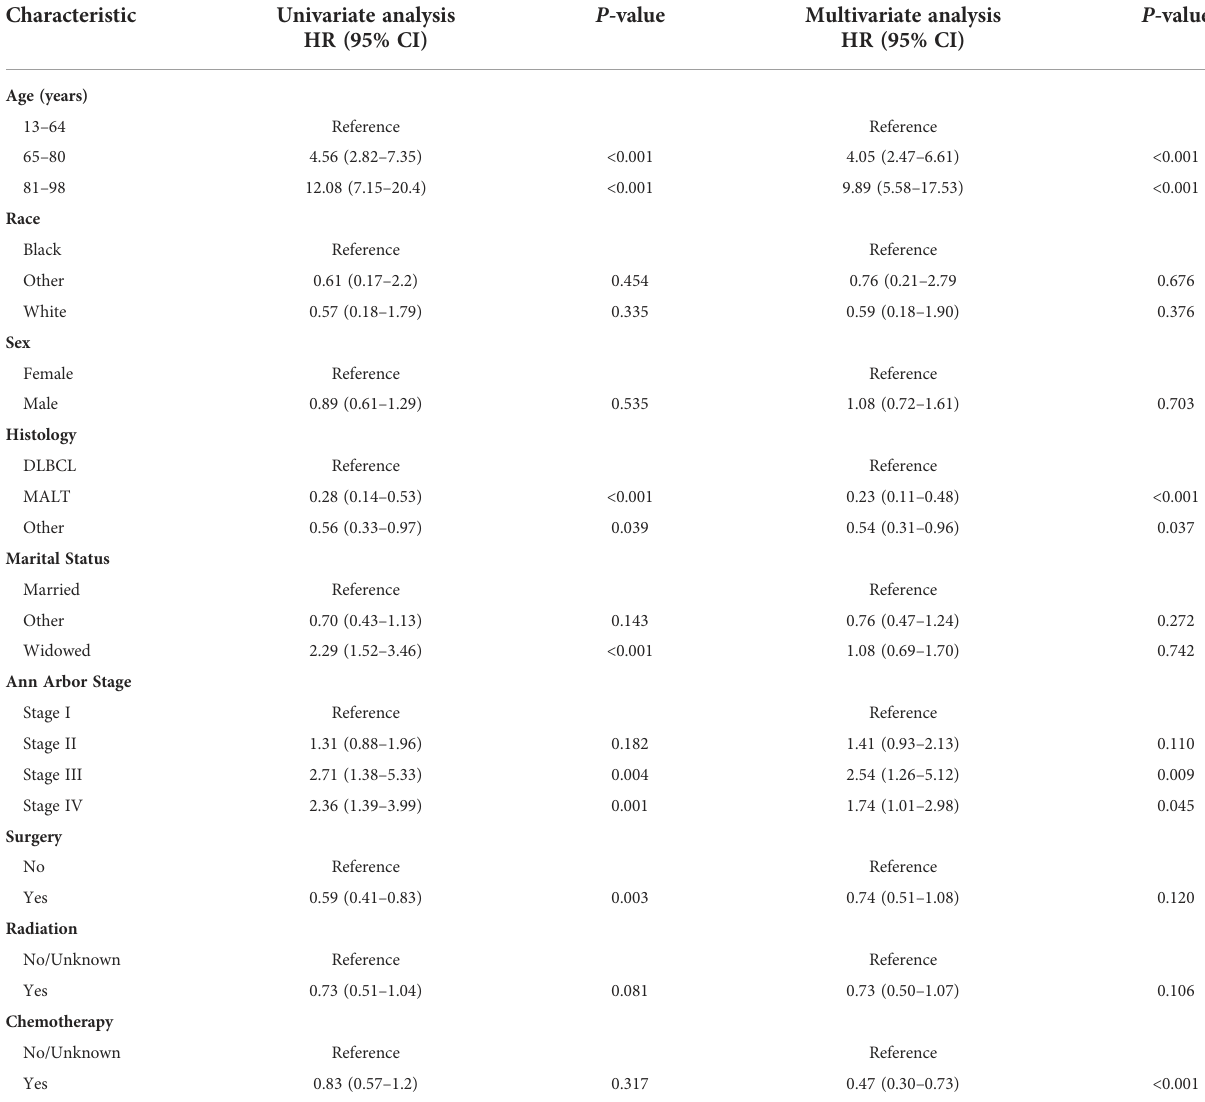
TABLE 2 Univariate and multivariate Cox regression analysis of BC-PTML-speci fi c survival (Training Cohort).